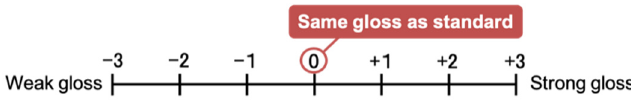
Figure 12. Rating scales.